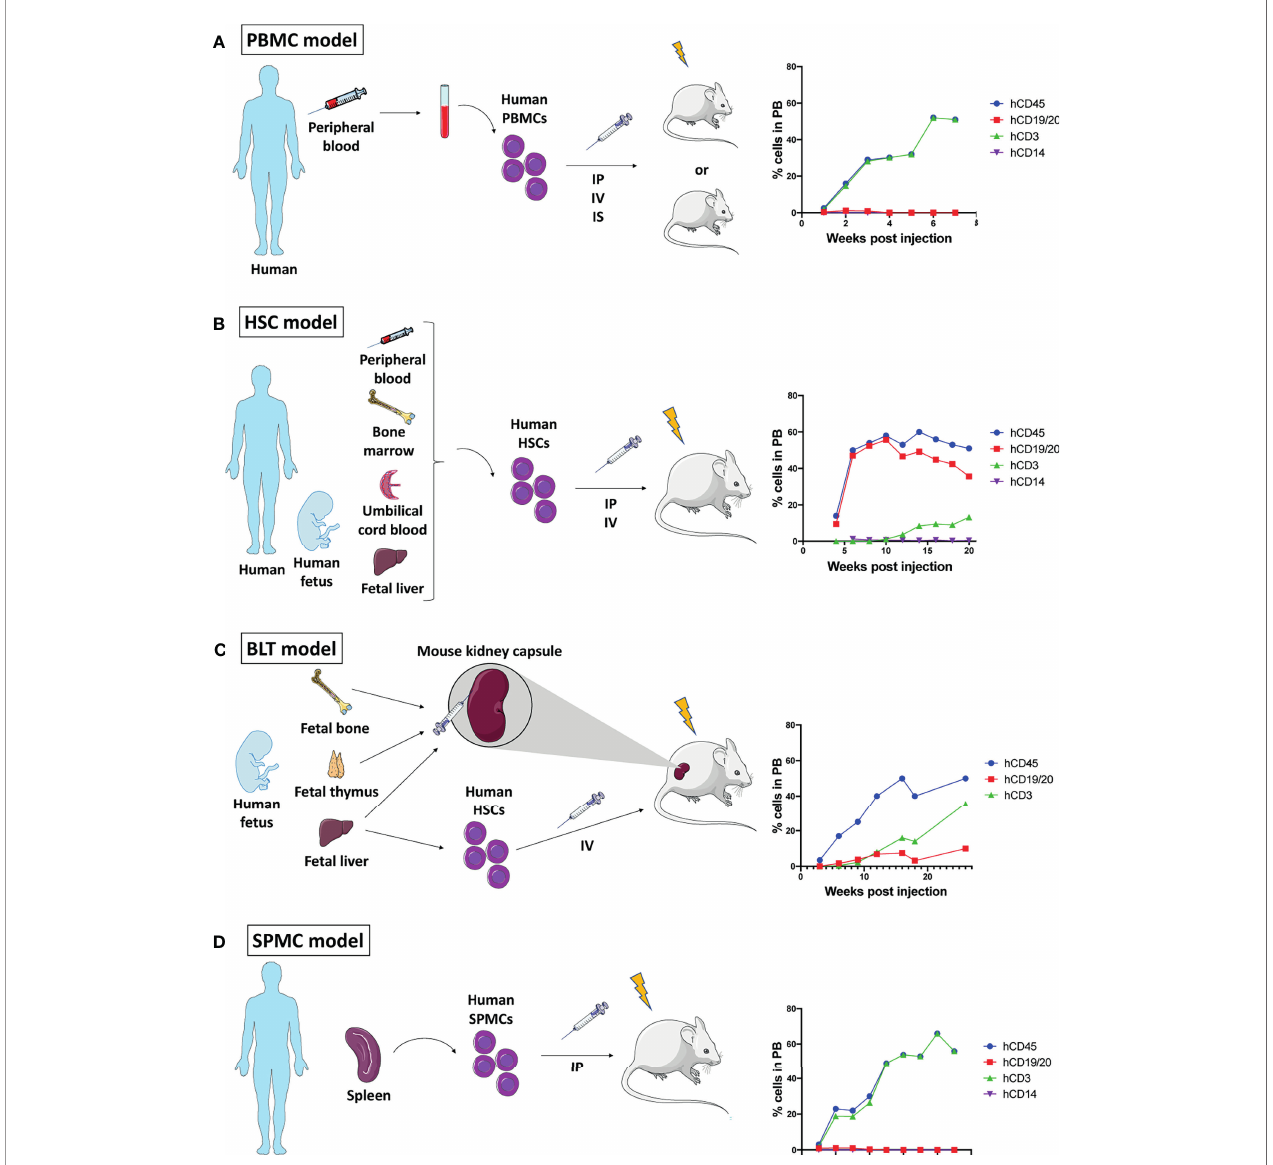
FIGURE 1 | Mouse humanization models. Schematic representation of the four humanization methods described, and graphs of their immune reconstitution in peripheral blood (PB) over time showing human CD45 + immune cells out of all blood leukocytes and human CD19/20 + B cells, human CD3 + T cells, and human CD14 + monocytes/macrophages out of human CD45 + cells. Immune reconstitution data showed on the graphs are gathered from different studies (10 – 14). (A) Generation of peripheral blood mononuclear cells (PBMCs) humanized mouse: Human PBMCs isolated from peripheral blood are engrafted into a low dose whole body irradiated or non-irradiated immunocompromised mouse by intraperitoneal (IP), intravenous (IV) or intrasplenic (IS) administration. (B) Generation of hematopoietic stem cells (HSCs) humanized mouse: Human HSCs isolated from either adult peripheral blood, bone marrow or umbilical cord blood, or from fetal liver are engrafted into a low dose irradiated immunocompromised mouse by IP or IV administration. (C) Generation of bone, liver, thymus (BLT) humanized mouse: Human fetal bone, thymus and liver tissue are co-transplanted under the kidney capsule of an immunocompromised mouse which is then irradiated and injected IV with human HSCs isolated from fetal liver. (D) Generation of spleen mononuclear cell (SPMC) humanized mouse: Human SPMC isolated from an adult spleen are engrafted into a low dose irradiated immunocompromised mouse by IP